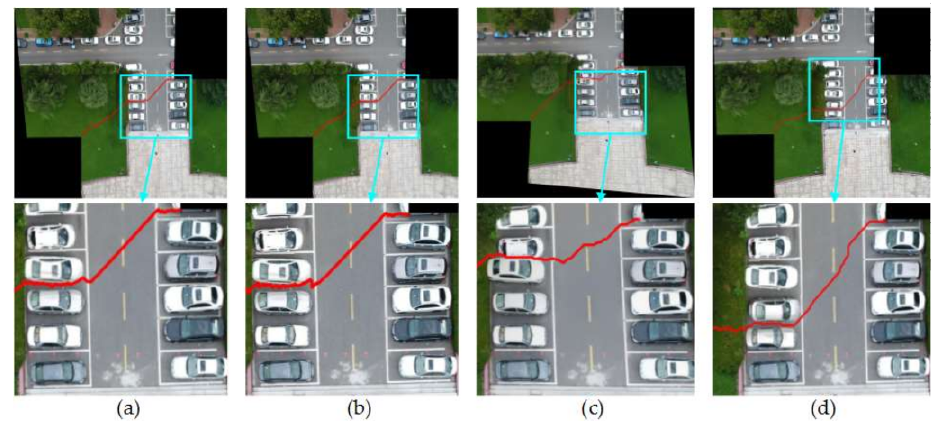
Figure 9. The seam-lines of different search methods for Figure 7b: ( a ) Dulapquet3-DP; ( b ) Dulapquet4-DP; ( c ) OpenCV-DP; ( d ) Our-Flow-DP.